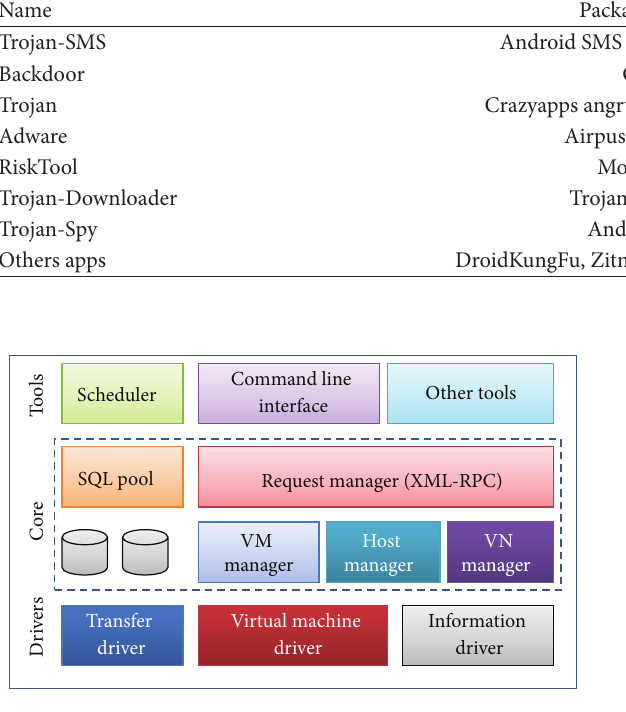
Figure 8: The three layers of the private cloud internal architecture.